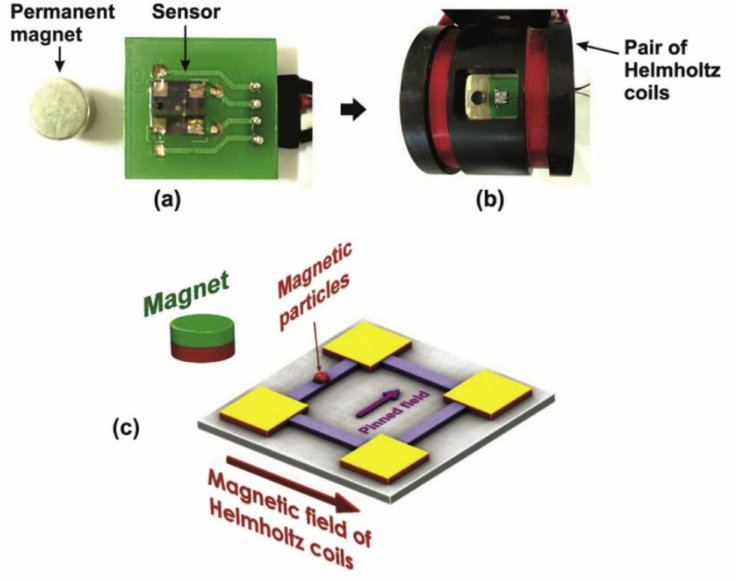
Figure 14. The experimental setup for the AMR magnetic particle detector in the Wheatstone bridge configuration is shown. ( a ) The AMR Wheatstone bridge device, ( b ) The chip in Helmholtz coils, and ( c ) The magnetic field components. Reprinted with permission from L.K. Quynh et al., 2016 Journal of Science: Advanced Materials and Devices 1(1), 98–102 [127]. Copyright 2016 Elsevier, under the terms of the Creative Commons CC-BY license http://creativecommons.org/licenses/by/4.0/, accessed on 28 June